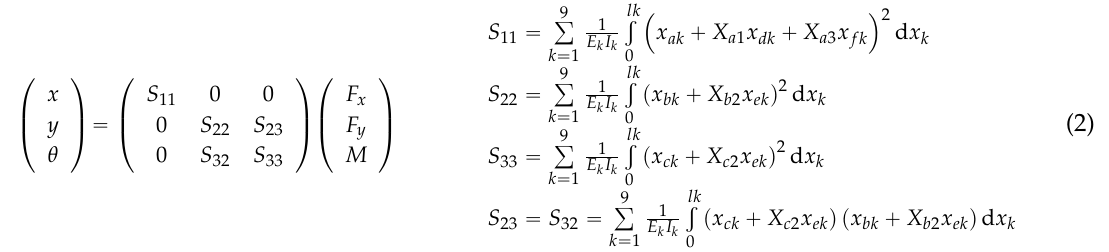
Internal generalized unit forces are obtained by solving the canonical equation. Based on Castigliano’s second theorem, the flexibility matrix derivation of operation modes (anti-phase modes) is formulated, as illustrated in Equation (2):